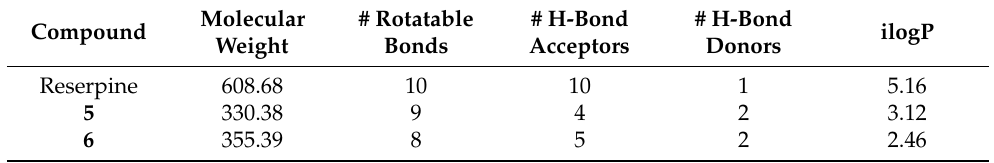
Table 3. Swiss ADME parameters for Lipinski’s rules for reserpine, compound 5 and compound 6